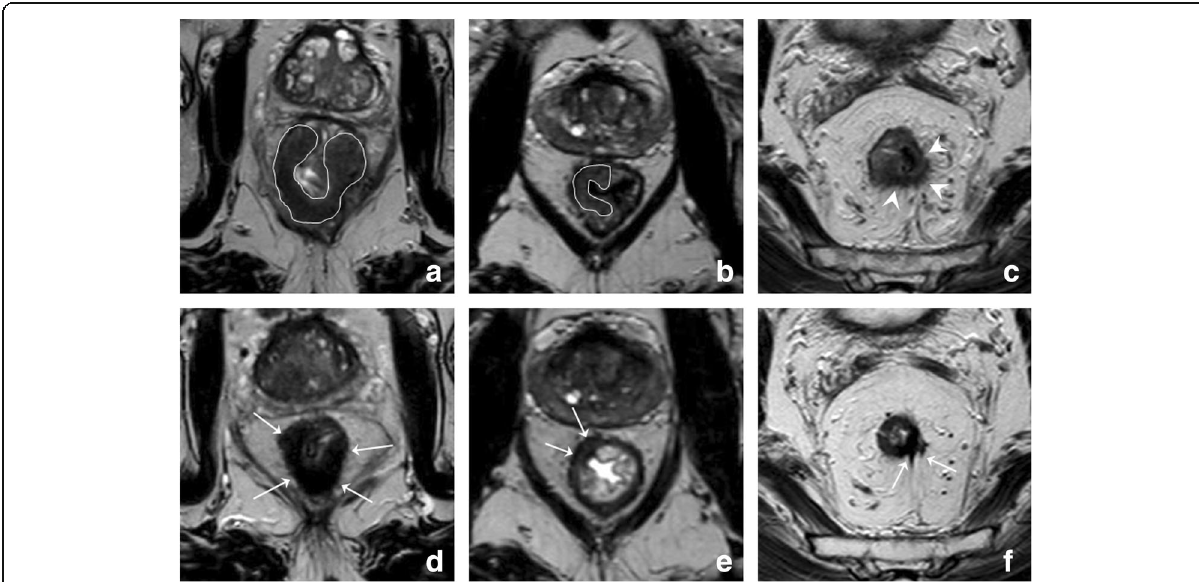
Fig. 2 Patterns of fibrosis. Examples of the pre-CRT ( a – c ) and corresponding post-CRT ( d – f ) T2-weighted images of three male patients with low to mid-rectal tumors. The first patient has a well-defined, almost circular tumor mass ( a ). After CRT ( d ), the tumor has undergone fibrotic transformation that follows the shape of the primary tumor, resulting in a full thickness (semi) circular fibrotic wall thickening. The second patient has a relatively small, semicircular tumor ( b ). After CRT, only a small focal area of fibrosis remains visible that is confined to the rectal wall ( e ). The third patient has an irregularly shaped, spiculated tumor ( c ). After CRT, the fibrosis also has an irregular aspect with persistent spiculations ( f